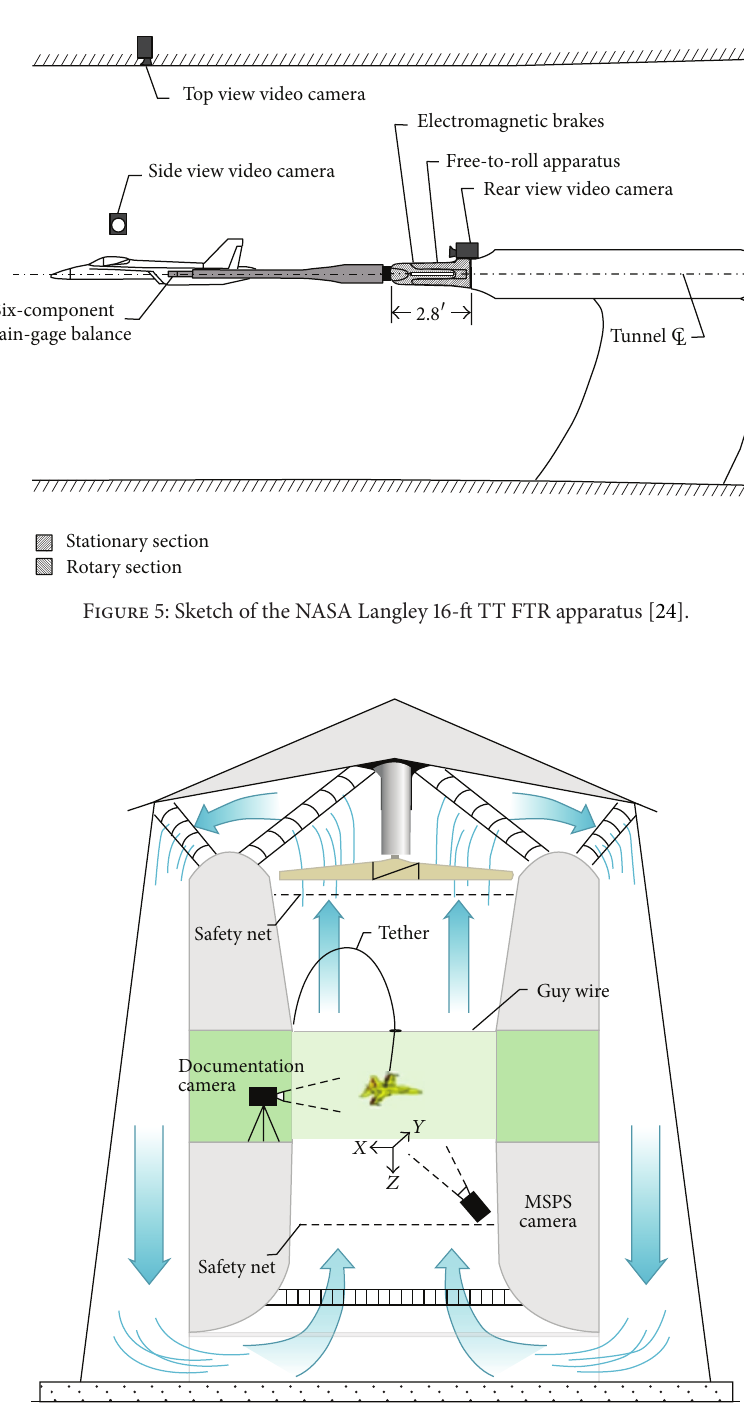
Figure 6: A cutaway drawing of the VST in NASA